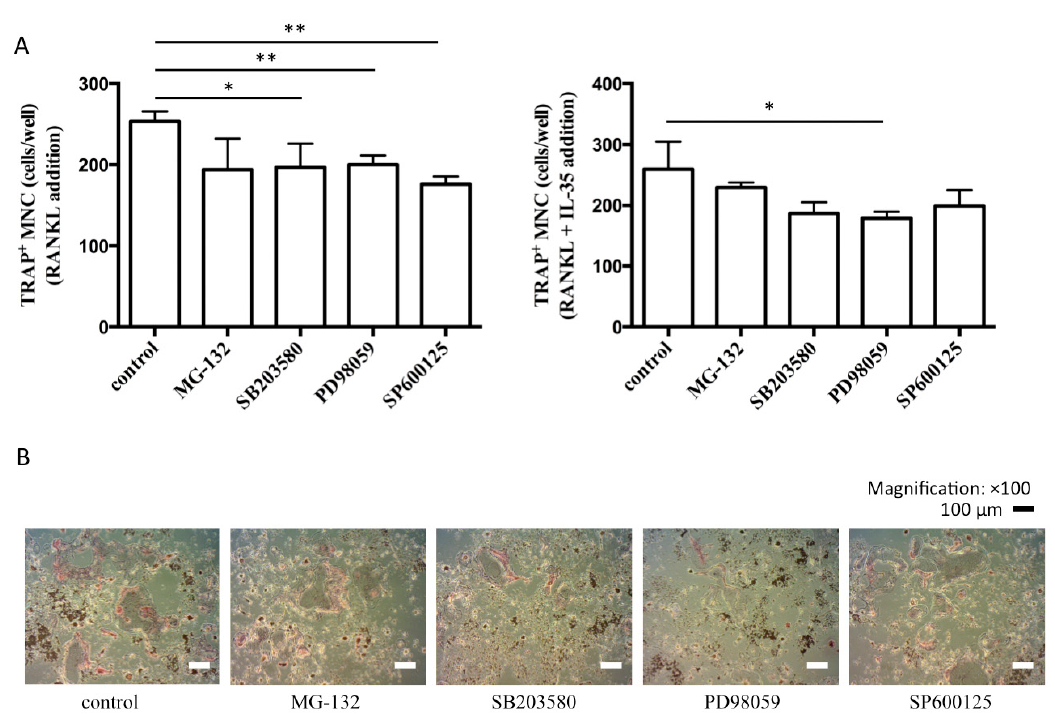
Figure 5. ERK signaling pathway is associated with IL-35-dependent osteoclastogenesis. ( A ) RAW cells were pretreated with each specific inhibitor for 1 h and then stimulated with 50 ng/mL RANKL together with or without 100 ng/mL IL-35 for 5 days. TRAP-positive multinucleated cells were counted as osteoclasts. Differences among groups were analyzed by one-way ANOVA. Data represent the mean ± SD ( n = 3). * p < 0.05, ** p < 0.01 vs. control. ( B ) RAW cells were pretreated with each specific inhibitor and then stimulated with 50 ng/mL RANKL and 100 ng/mL IL-35. After 5 days, the cells were fixed and stained for TRAP.